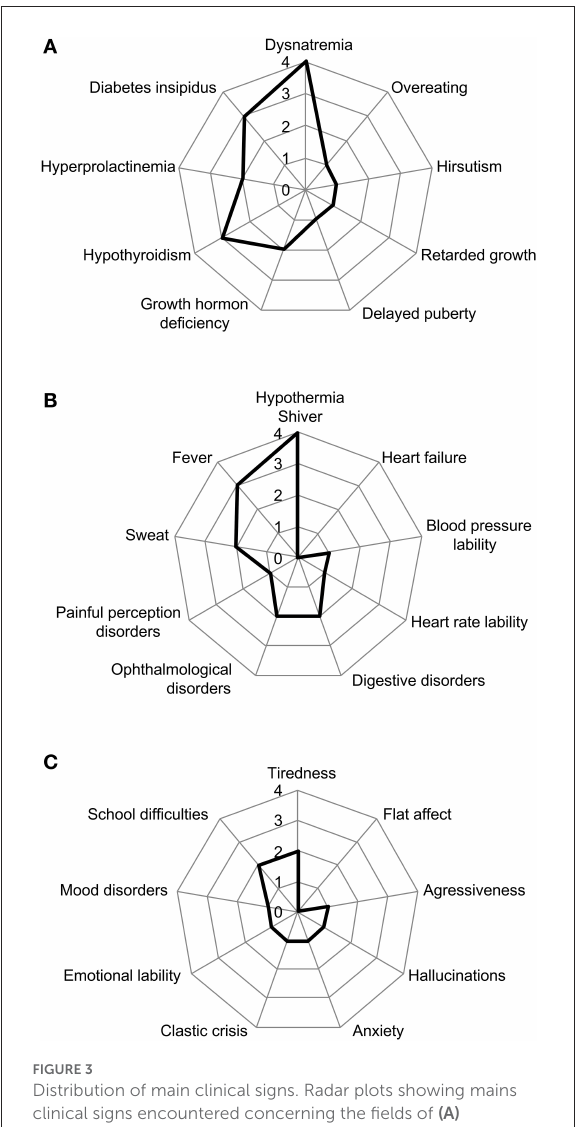
FIGURE3 Distribution of main clinical signs. Radar plots showing mains clinical signs encountered concerning the fields of (A) hypothalamic dysfunction, (B) dysautonomia, (C) behavioral disorders.